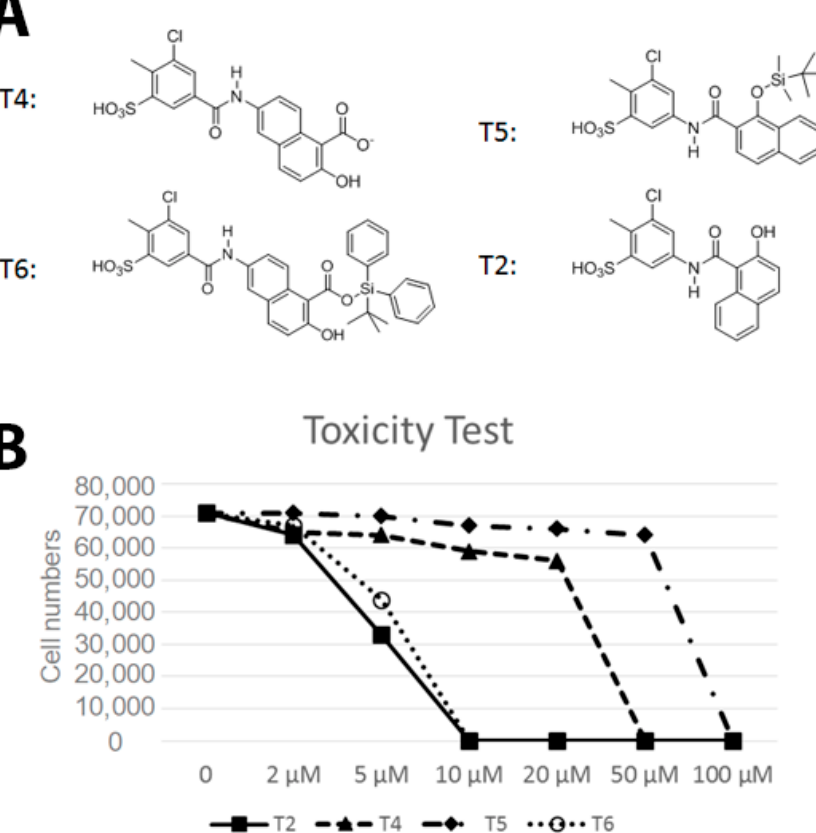
Figure 6. Effect of small molecule inhibitors on cell viability. ( A ) To determine the minimum concentration at which the small molecule inhibitors can be tolerated by cells, four inhibitors were chosen based on their effect on the DNA binding by Vezf1 in gel shift assays. ( B ) MSS31 cells were treated with inhibiots for 24 h and live cells were counted using Trypan blue exclusion test and plotted against the concentration of the inhibitors used. Whereas T5 and T6 were deleterious at very low concentrations, T4, which as a lowest IC50 of 20 µ M, was tolerated by cells in this range. 2.7. T4 Treated MSS31 Cells Are Incapable of Tube Formation in Matrigel ™ Vezf1 has a critical function in differentiation of endothelial cells and angiogenesis.